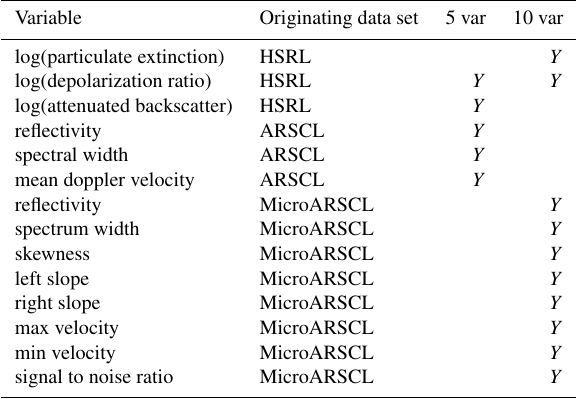
Table 2. Lists variables used in the 5- and 10-variable algorithms. All variables from the MicroARSCL data set refer to the primary peak detected in the Doppler velocity spectrum.